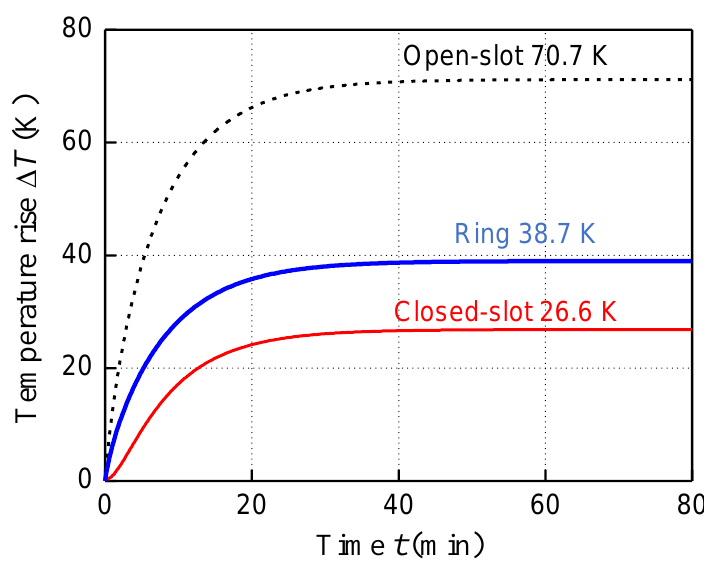
Figure 11. Time transition of temperature rise at magnets ( N = 30,000 rpm, P o = 500 W).